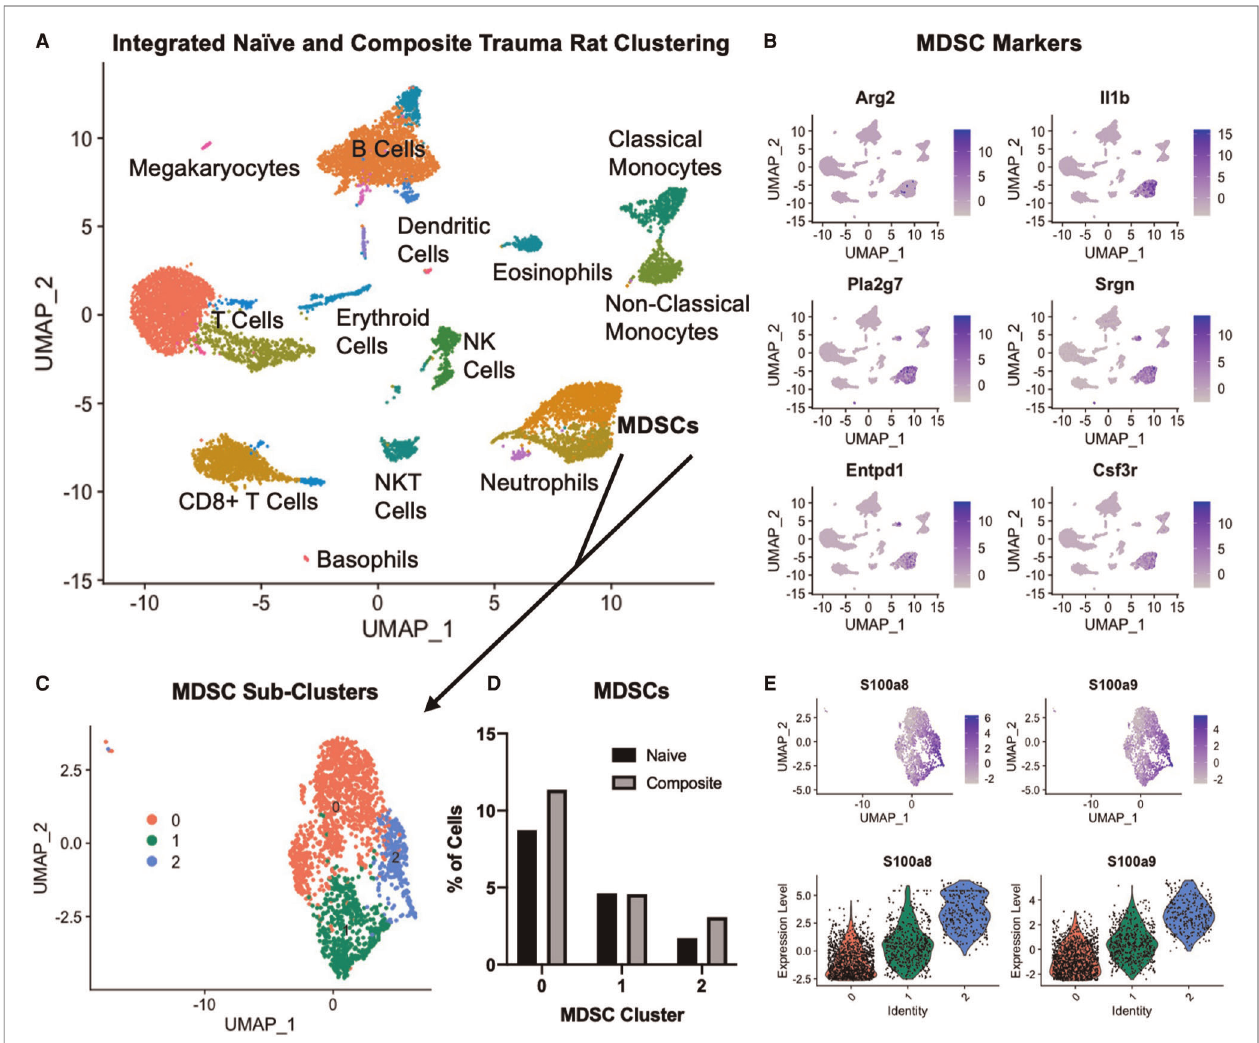
FIGURE 7 | Single cell RNA sequencing in the composite trauma model. ( A ) Integrated clustering of PBMCs from naïve and composite trauma rats at 5 days post- injury. ( B ) Gene expression of MDSC gene markers. ( C ) MDSC clusters identi fi ed in ( A ) were re-integrated and re-clustered for more in-depth analysis. Three subclusters were identi fi ed. ( D ) Comparison of MDSC percentages for clusters 0, 1, and 2 in composite trauma model rats versus naïve rats. ( E ) Density plots (top) and violin plots (bottom) of S100a8 expression (left) and S100a9 expression